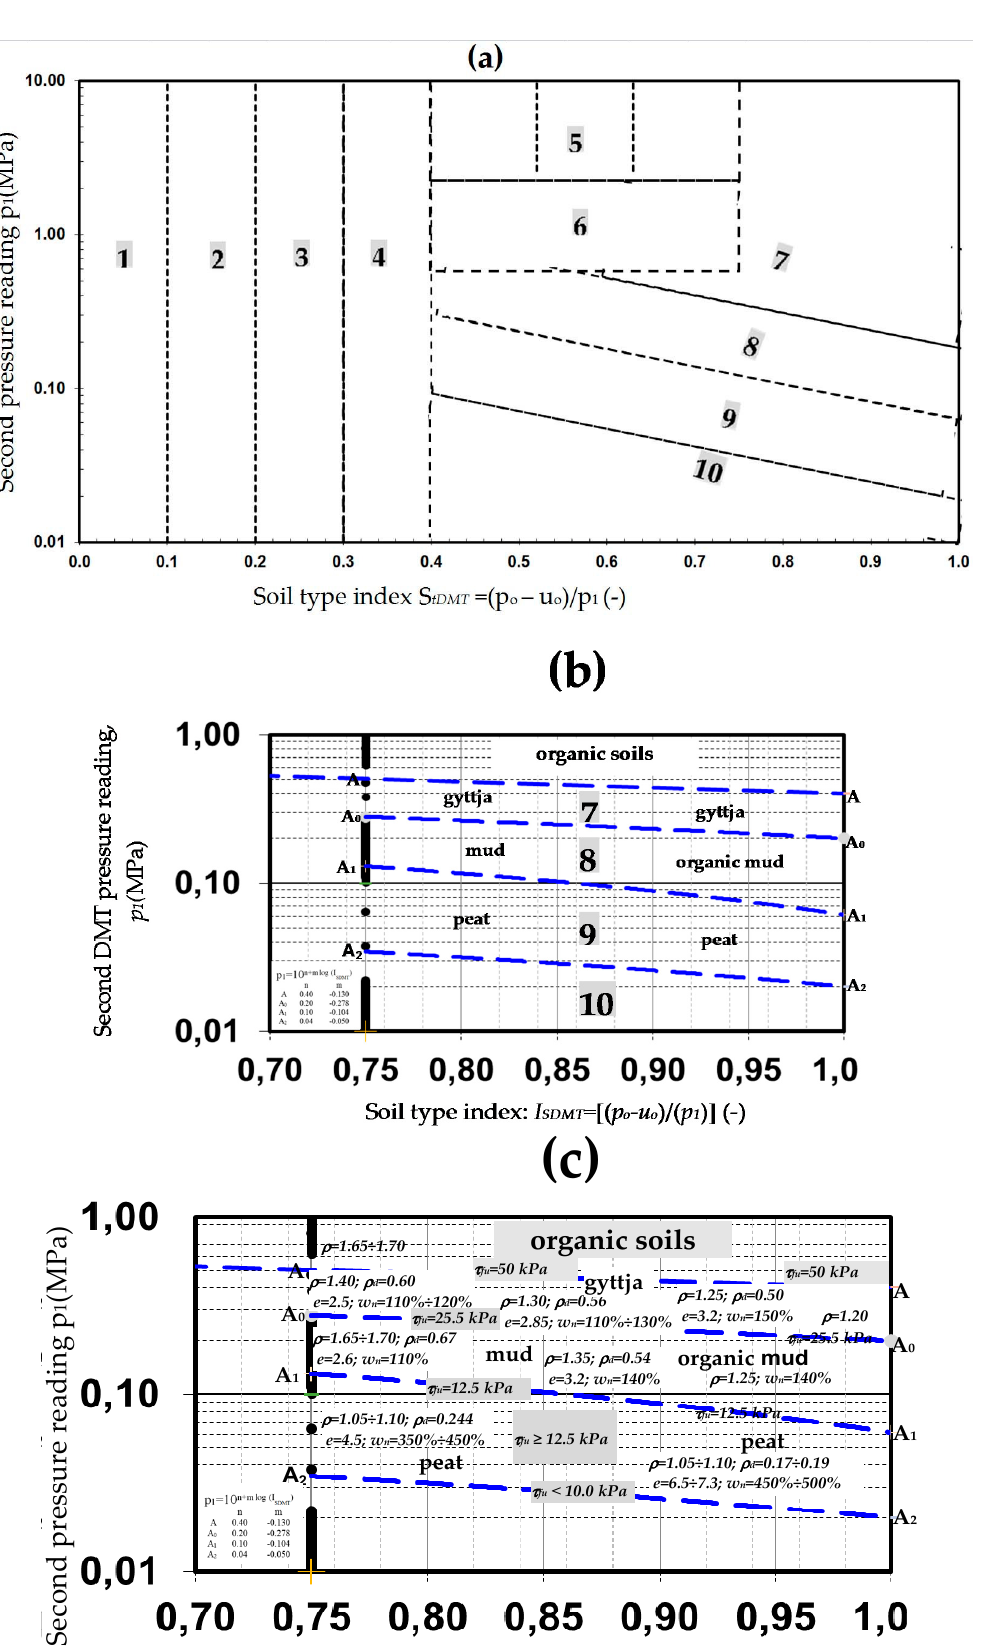
Figure 11. Chart estimating the type and state of residual mineral soils and organic soils.